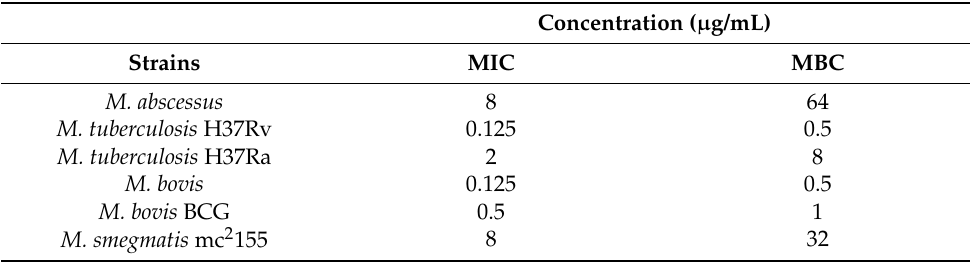
Table 1. MICs and MBCs of oritavancin against M. abscessus and M. tuberculosis